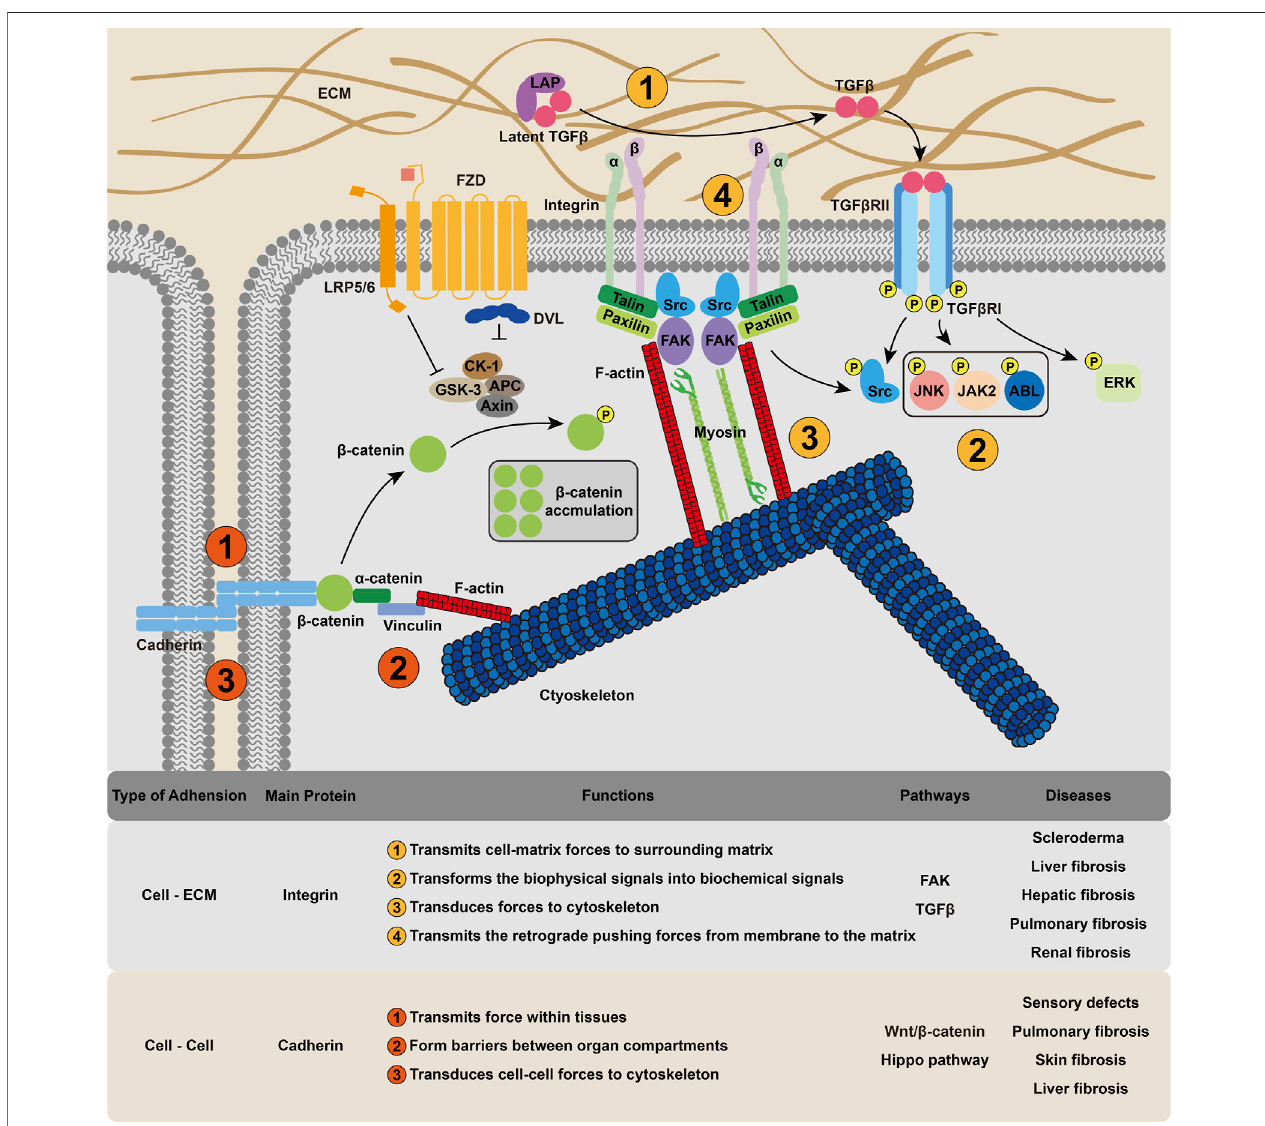
FIGURE1| Cellularmechanosensingmechanismin fi brosis.Cellcouldreceiveandintergratemechanicalsignalsthroughintegrin-basedcell – ECMinteractionsand cadherin-based cell – cell interactions, transforming the extracellular physical cues into membrane tension and cytoskeleton deformation.